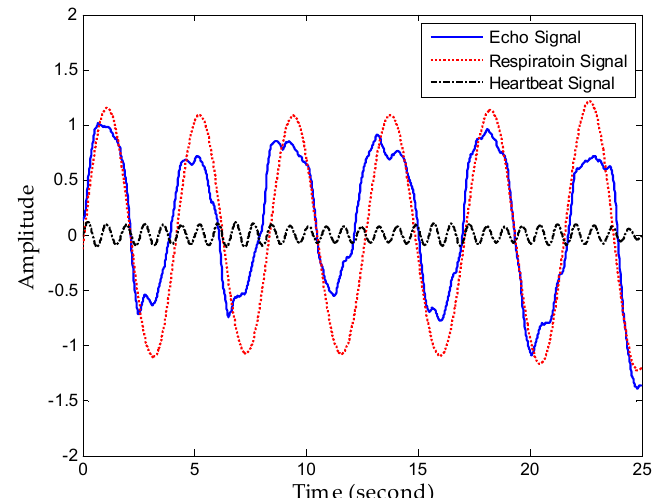
Figure 12. Performance of separation. Sensors 2016 , 16 , 2025